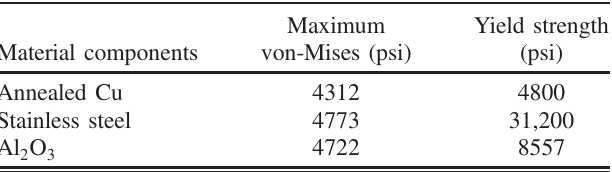
TABLE III. 5 g shock load simulation